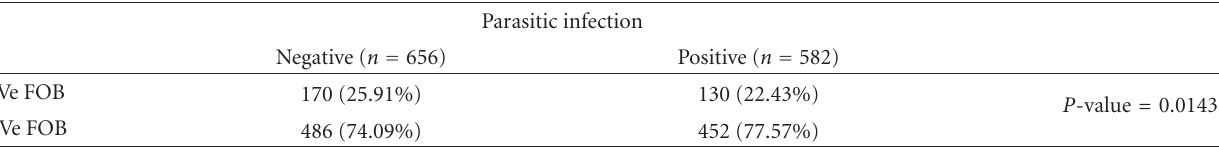
Table 1: FOB finding in negative (control) and positive parasitic infections.